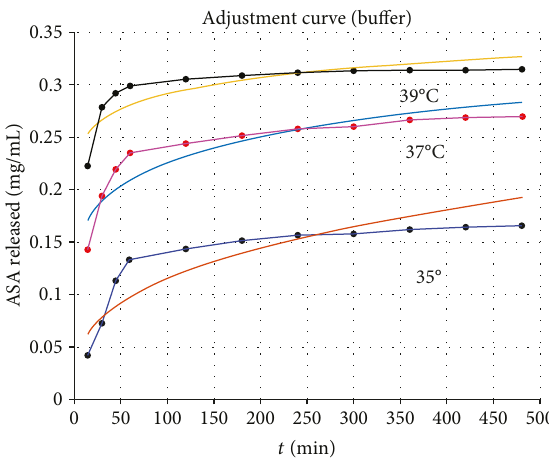
Figure 7: Adjustment curve for ASA released with bu ff er solution experimental data using Matlab.